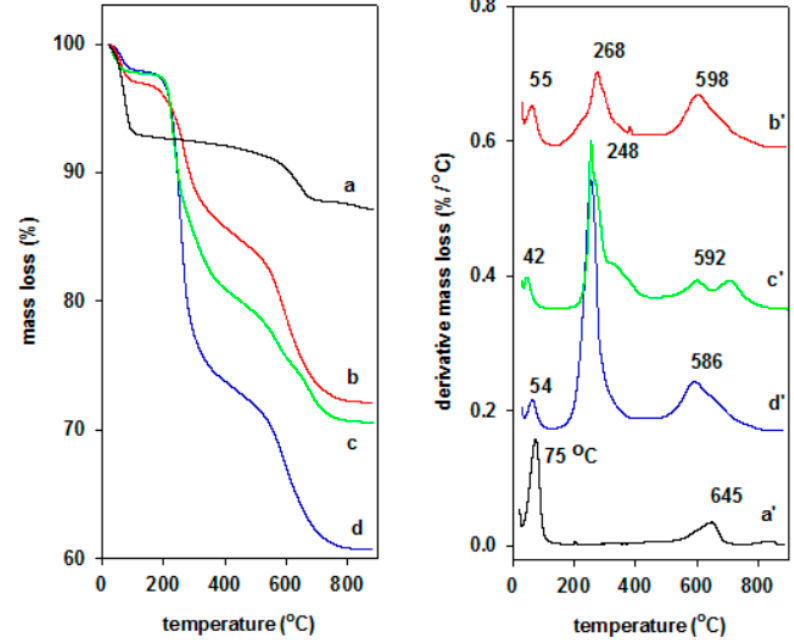
Figure 7. TGA (left) and DTG (right) fetaures of ( a , a’ ) cloisite raw clay exchanged with different C16 solutions ( b , b’ ) C16OH, ( c , c’ ) C16Cl, and ( d , d’ ) C16Br.